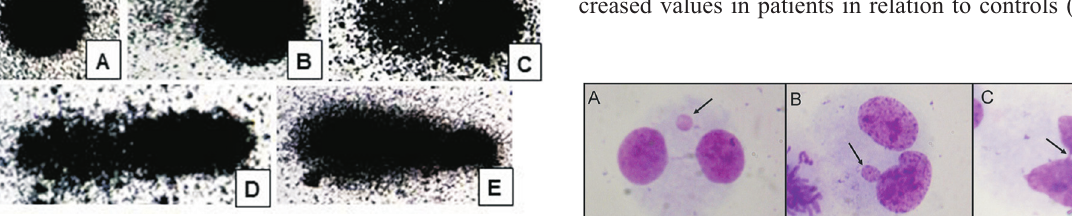
Figure 2 - Comet assay: nuclei of leucocytes exhibiting different levels of DNAdamage.A:score0(nomigration);B:score1;C:score2;D:score3, and E: score 4 (maximal migration).